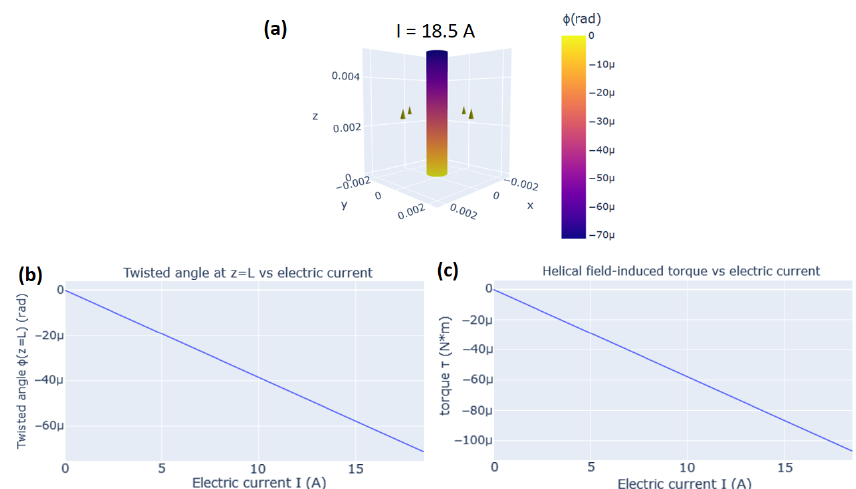
Figure 9. Simulation of the Wiedemann effect for a Ni wire. ( a ) 3D visualization of the twisted angle as function of the z-coordinate, φ ( z ) , of the rod with applied electric current I = 18.5 A. The green arrows at z = L /2 represent the magnetic field H (cid:107) + H ⊥ . ( b ) Twisted angle at z = L , φ ( L ) , versus the